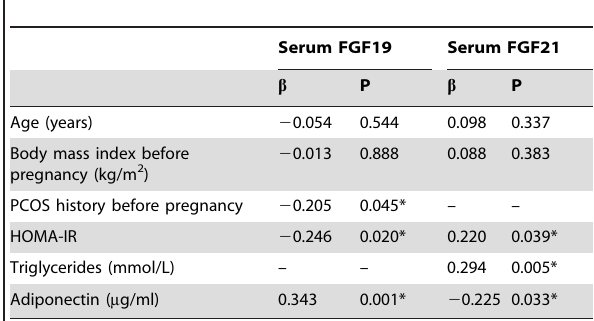
b Coefficients and P values are given. Abbreviations are indicated in Table 1. *Significant